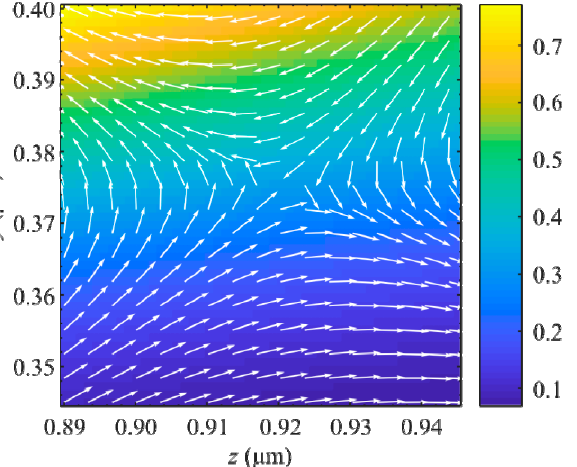
Figure 6. Intensity distribution (color) and direction of the Poynting vector (arrows) in the region of